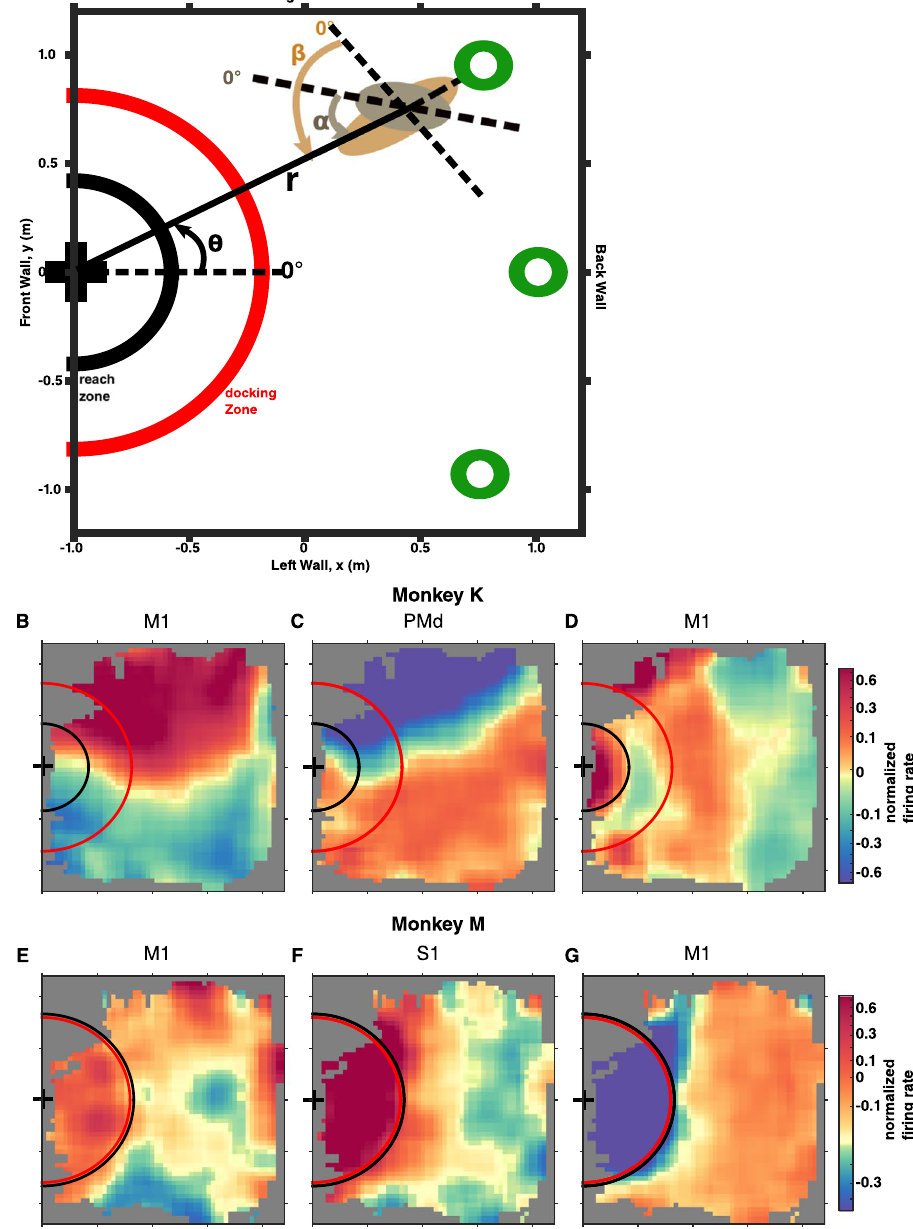
Figure 1. Wheelchair navigation setup and examples of spatially-selective neurons. ( A ) View from the top of the experimental room, where the monkey navigated in a motorized wheelchair under BMI control from one of three possible starting locations (shown as green circles) to the grape dispenser (marked by a ‘ + ’). The four walls of the experiment room are labeled as “front”, “back” “right” and “left”, which correspond to the monkey facing the grape dispenser and navigating from the back to the front of the room. Red semicircle labels the docking zone upon which an auto-pilot took over the wheelchair control. Black semicircle labels the reach zone within which monkeys initiated reach movements for the grape. The position of the monkey’s body and orientation of the head (gray ellipse) and trunk (tan ellipse) were evaluated using the following coordinates: θ - the angle of the wheelchair’s location with respect to the dispenser; r – the distance from the wheelchair to the dispenser; α – the angle of the dispenser location with respect to the monkey’s head direction; and β – the angle of the dispenser location with respect to the wheelchair’s direction. (B – D) Spatial tuning diagrams in representative neurons from monkey K and monkey M (E – G) , axis labels as in (A) . Color represents trial- average z-scored firing rates for different room locations. Cortical areas, where the neurons were recorded, are